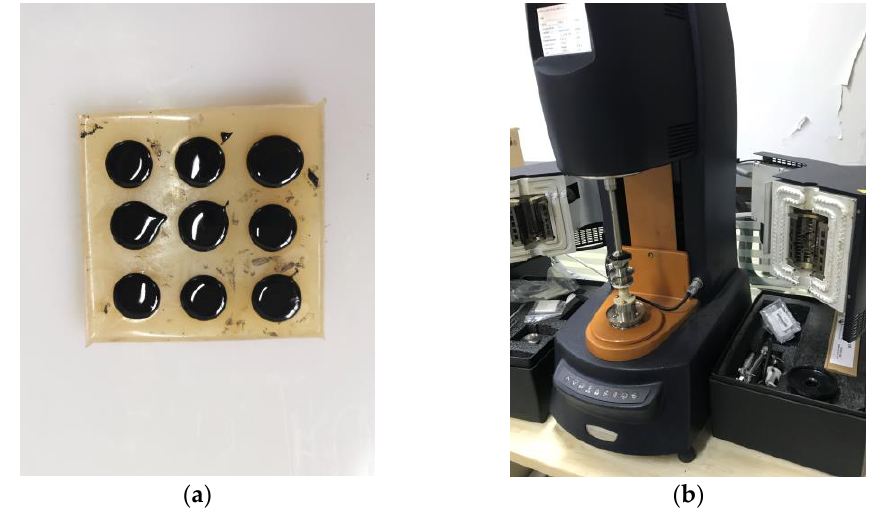
Figure 2. ( a ) (Dynamic shear rheometer) DSR and (Multiple Stress Creep Recovery) MSCR samples and ( b ) dynamic shear rheometer.